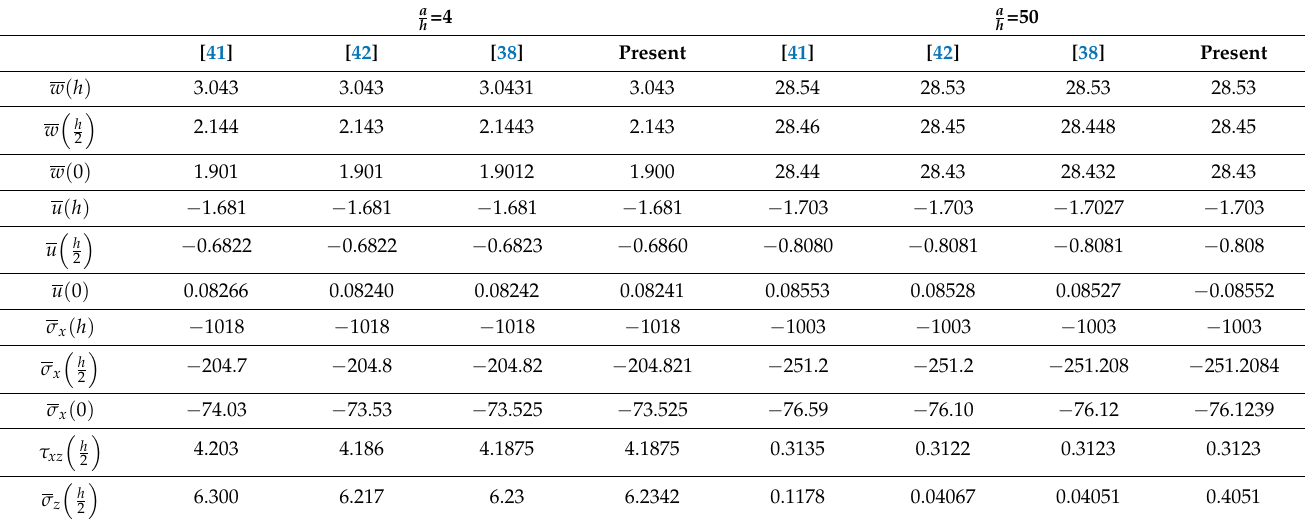
Table 2. Numerical result displacements for FGM square plate under a thermal load.